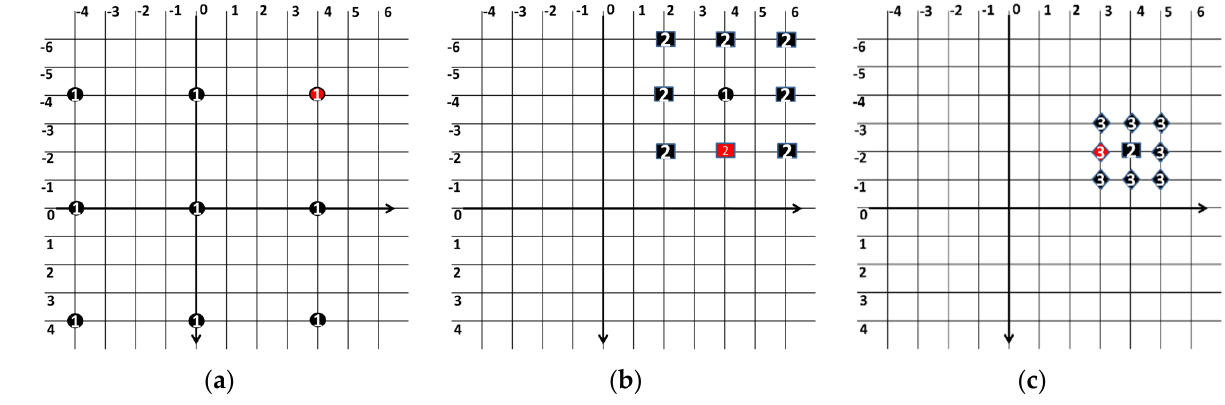
Figure 2. The rectangular search patterns of TSS at ( a ) first search step (assume s = ±7), ( b ) second search step, a rectangular search pattern is placed around the minimum search point of the first search step and the step size is half of the first step, ( c ) third search step, a rectangular search pattern step. The minimum search point at any search step is highlighted with red colour.